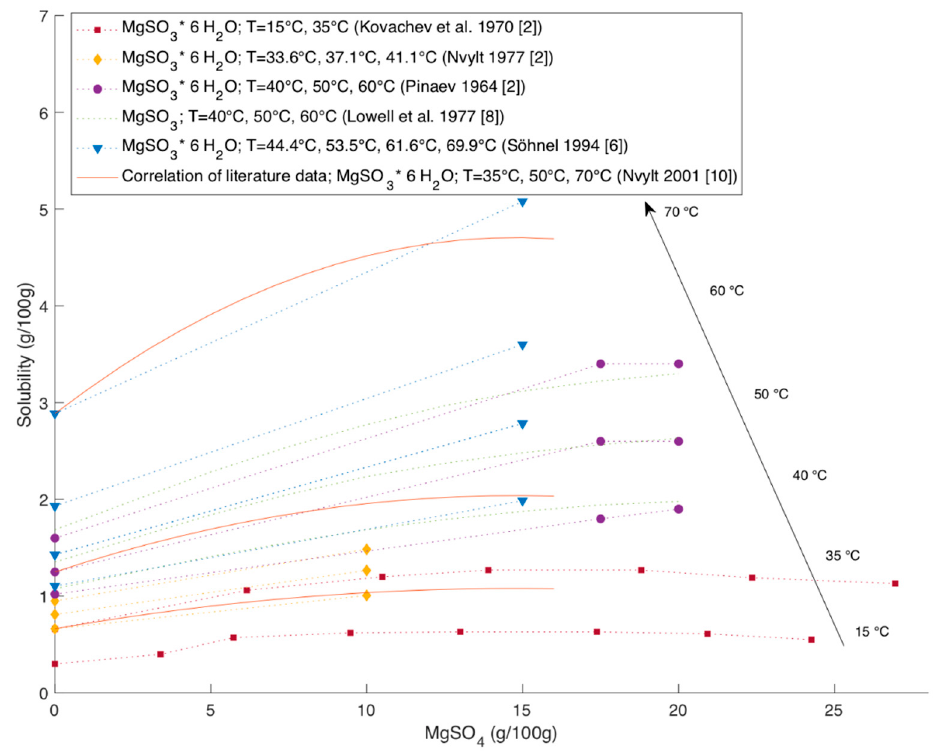
Figure 4. Solubility of MgSO 3 hexahydrate over MgSO 4 content at different temperatures [2,6,10].